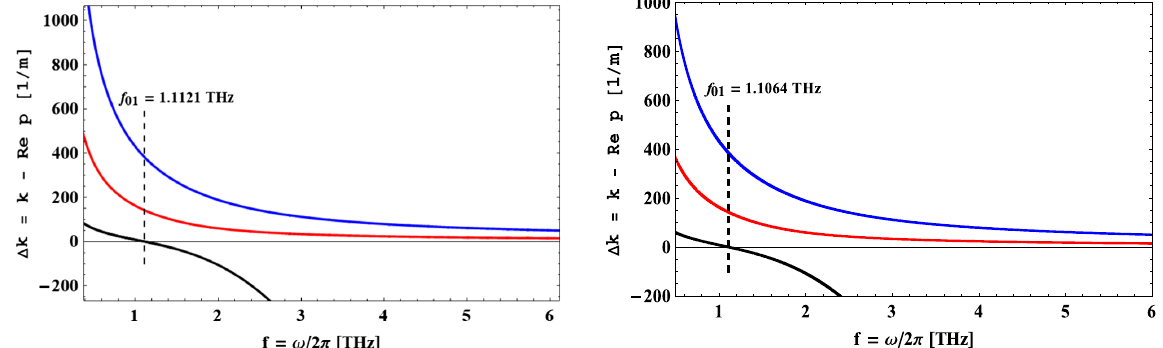
FIG. 11. Dispersion curves for the TM 01 (black line), TM 02 (red line), and TM 03 (blue line) modes: ε 00 1 ¼ 0 (left) and ε 00 1 ¼ 3 (right). Synchronous frequencies correspond to Δ k ¼ 0 , which is reached only for the TM 01 mode.